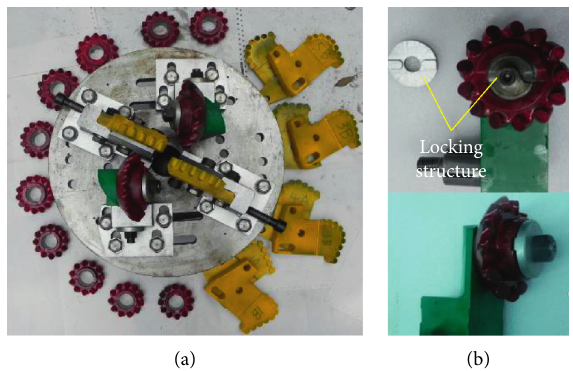
Figure 18: Structure of the experiment